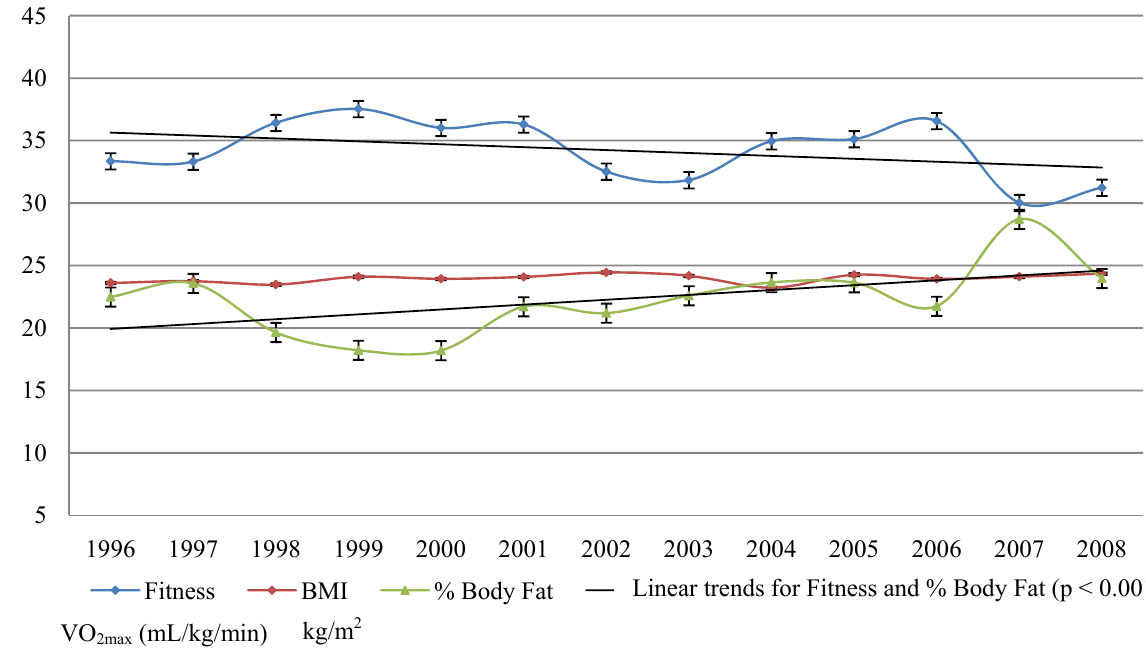
Linear trends for Fitness and % Body Fat (p < 0.001)